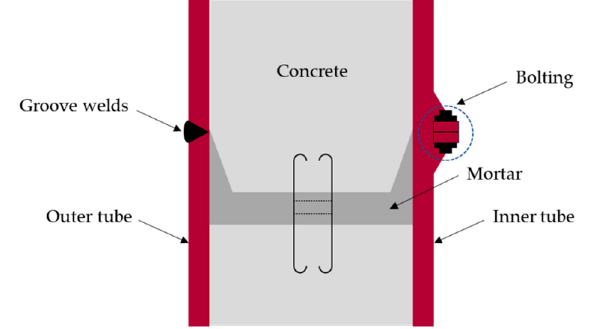
Figure 4. Connection by bolting, welding, and injected mortar.